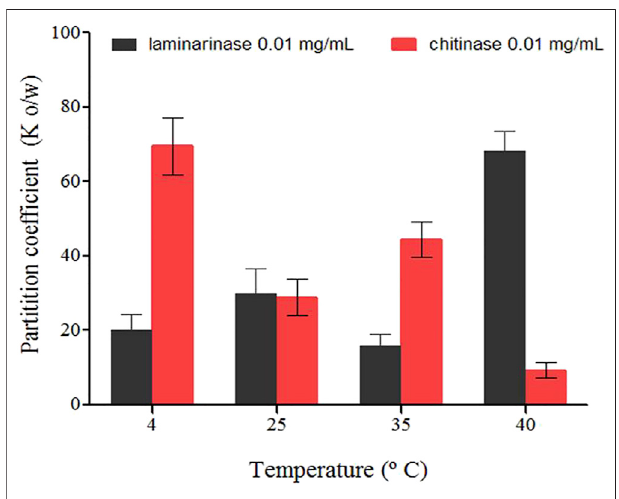
FIGURE4| Partitioncoef fi cientsofenzymes(laminarinaseandchitinase) in soybean lecithin liposomes system quanti fi ed for different temperatures ( ± 0.1 ° C), in molality ( ± standard